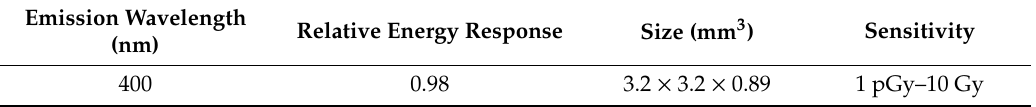
Table 1. TLD 100H